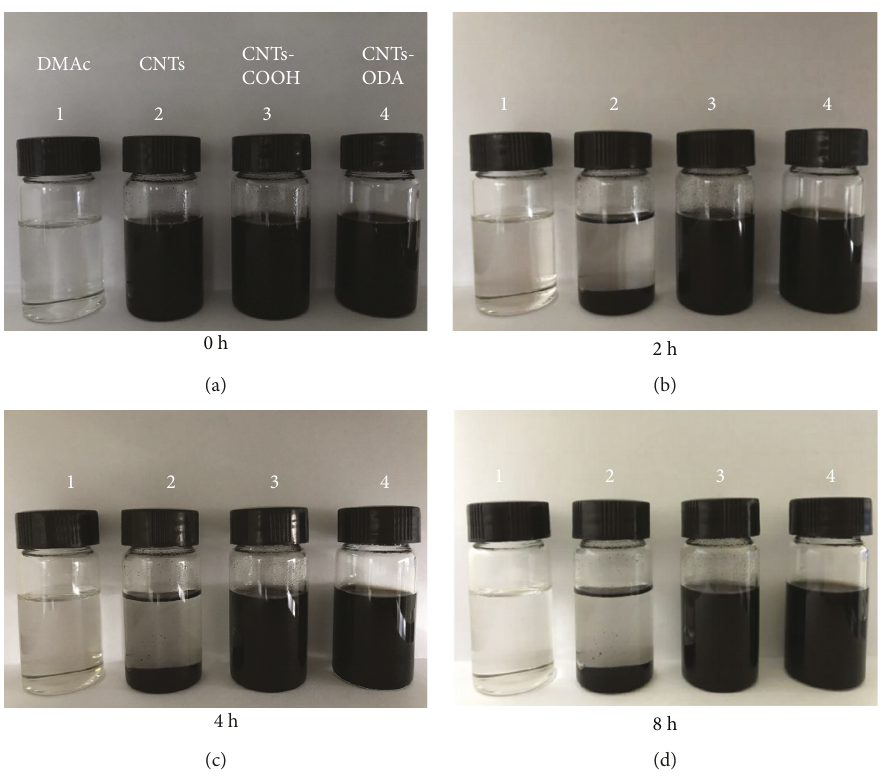
Figure 3: DMAc solvent, pure MWCNTs/DMAc mixture, MWCNTs-COOH/DMAc mixture, and MWCNTs-ODA/DMAc mixture allow standing for (a) 0h, (b) 2 h, (c) 4h, and (d) 8 h, respectively.